Question: Does the plotted quantity increase or decrease?
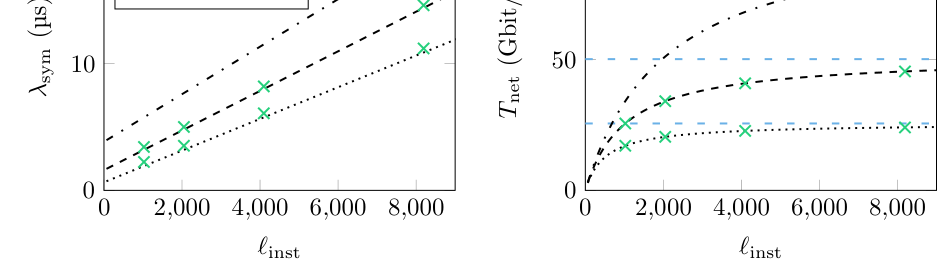
Answer: increasing